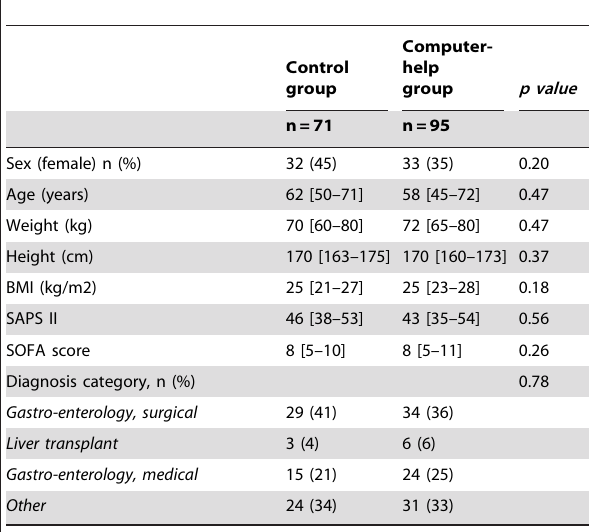
Table 1. Patients’ characteristics at admission to the